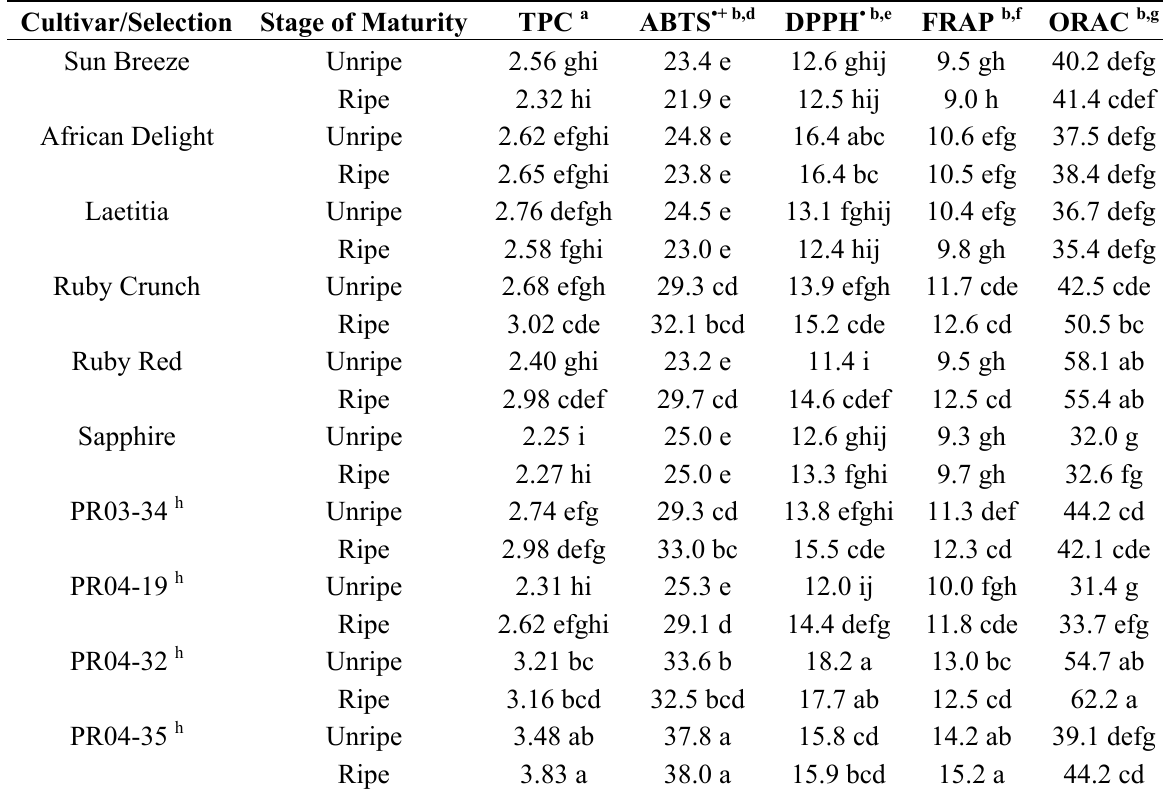
Table 4. Total polyphenol content (TPC) a and total antioxidant capacity (TAC) b of unripe and ripe fruits from South African plum ( Prunus salicina Lindl.) cultivars and selections of the second harvest season c